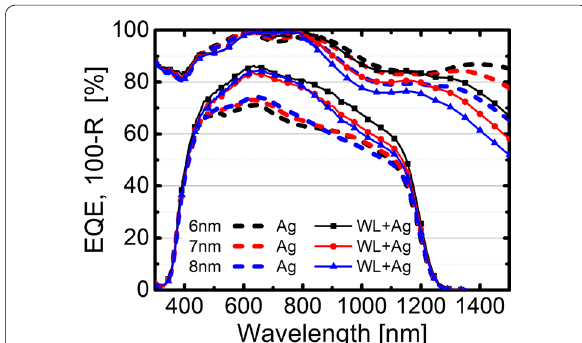
Fig. 6: 100‑EQE‑R, i.e. parasitical absorption and recombination losses of CIGS cells using OMO electrodes with (full lines) and without (dashed lines) wetting layers. After subtraction of both EQE and reflection from 100%, only the absorption not contributing to current generation